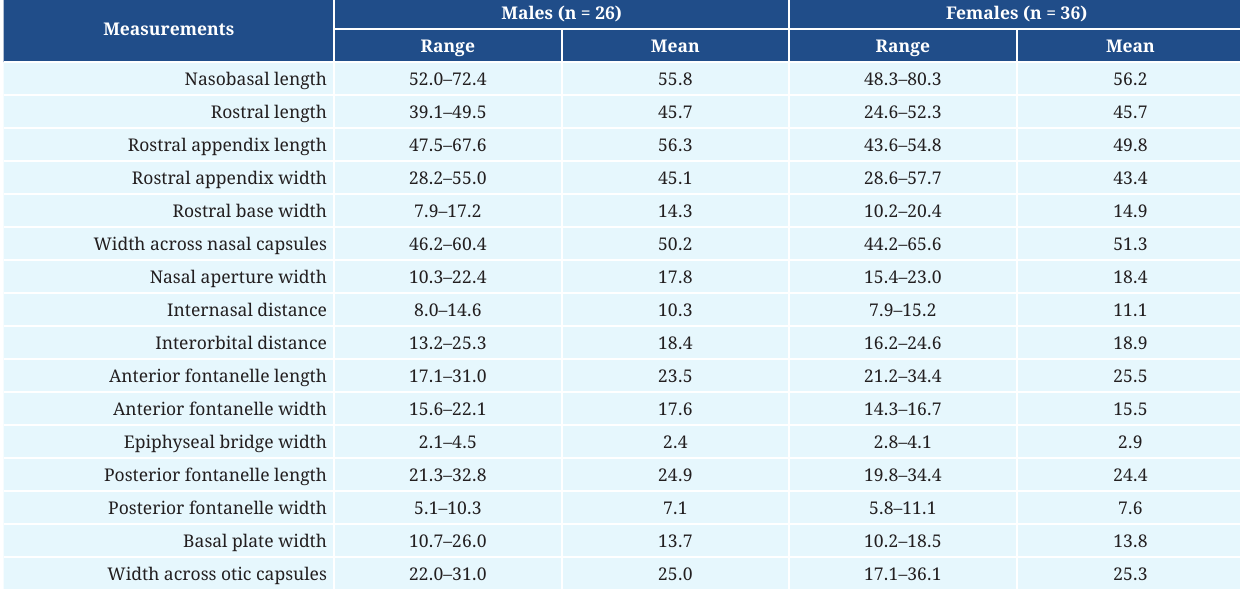
ni.bio.br | scielo.br/ni